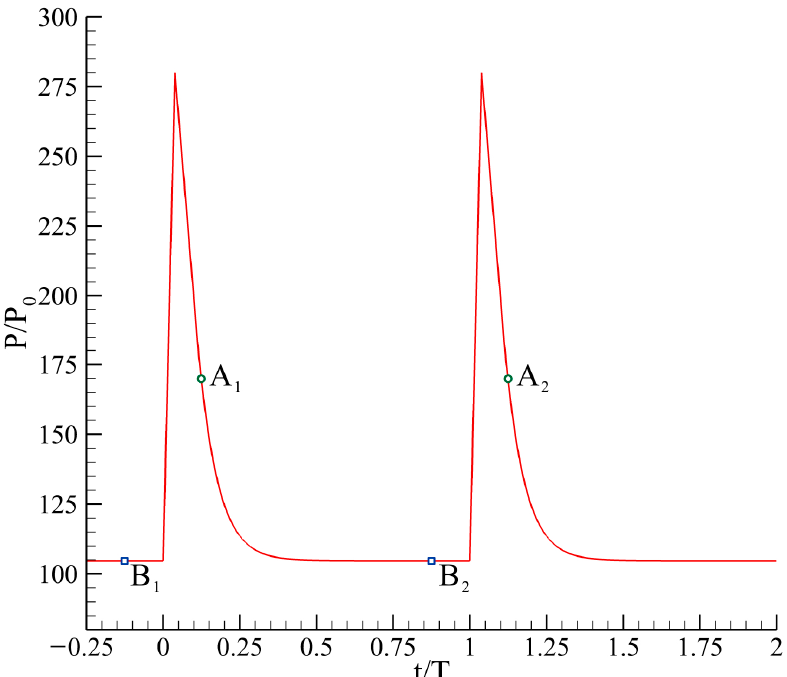
Figure 15. Feedback pressure change curve with time, where points A 1 and A 2 denote the meridian plane with θ = 135° at t = n T and t = (n + 1) T, respectively, and points B 1 and B 2 denote the meridian plane with θ = 225° at t = n T and t = (n + 1) T, respectively.